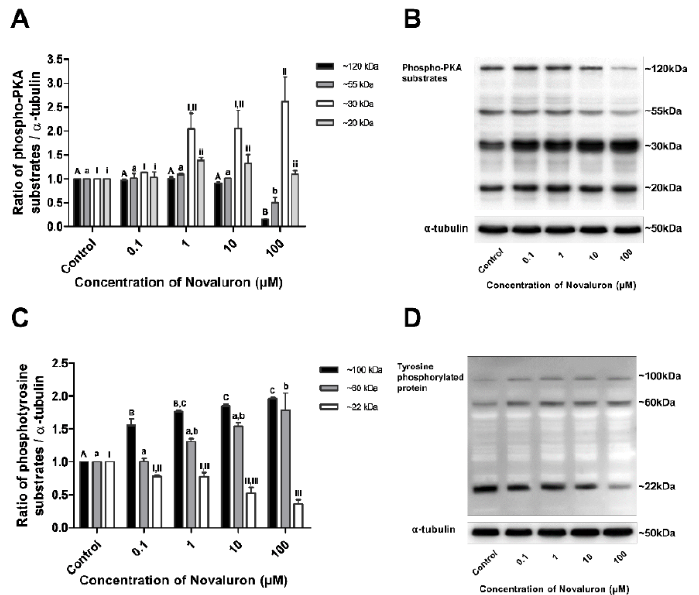
Figure 3. Effect of novaluron on PKA activity and protein tyrosine phosphorylation. ( A )